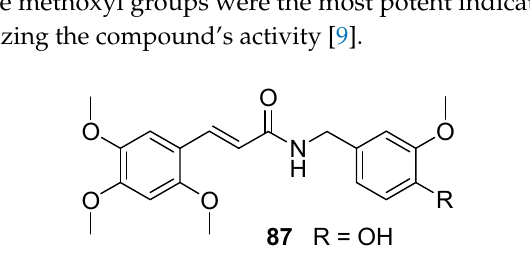
Figure 23. Chemical structure of compound 87 [9].